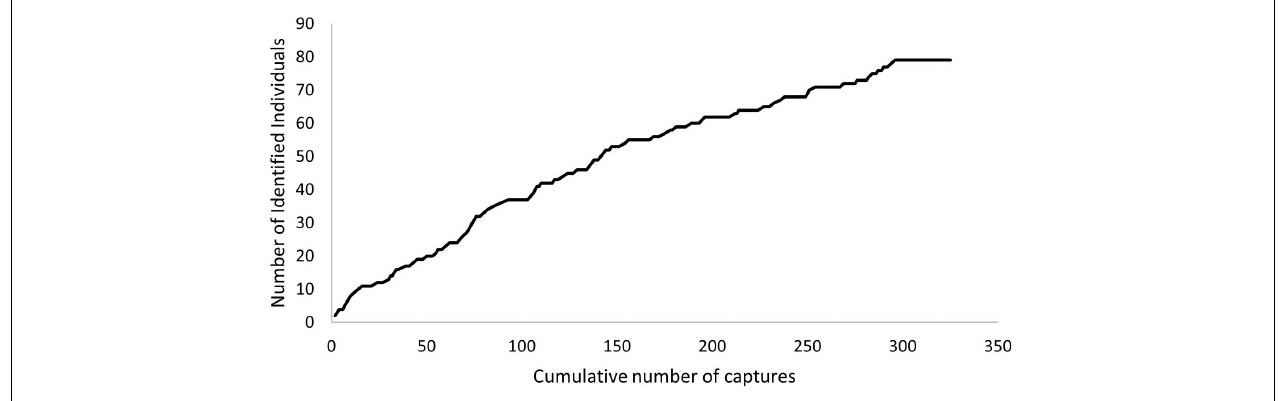
FIGURE 1 | Discovery curve for distinctive whales based on good quality